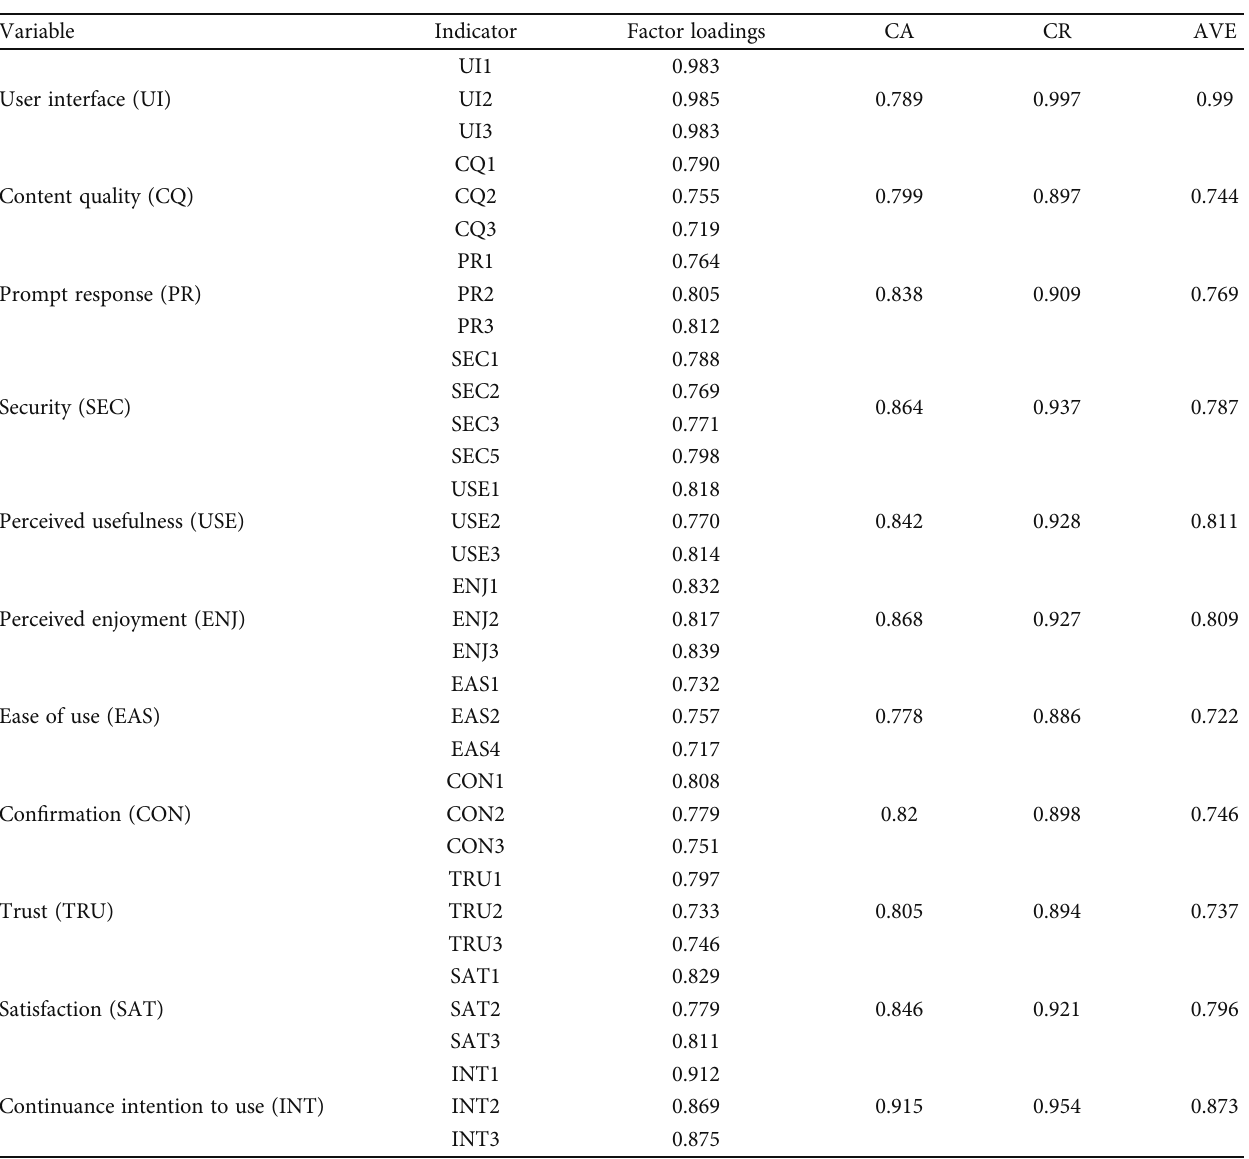
Table 3: Factor loadings, AVE, CR, and CA.